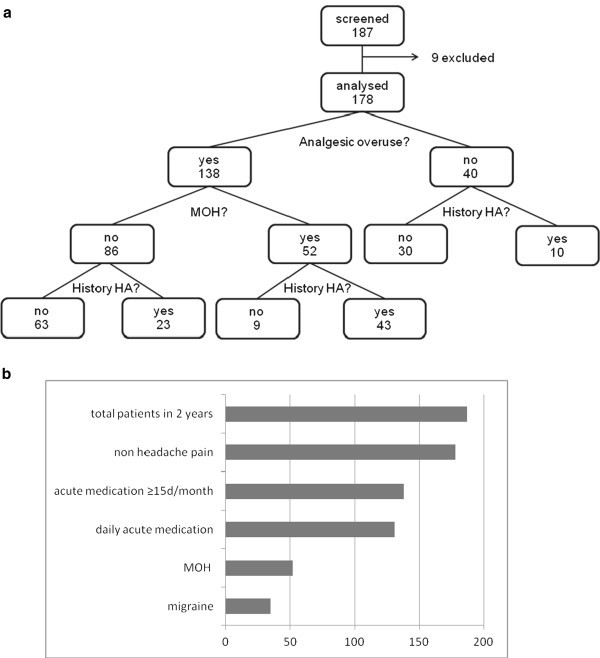
Patient population.